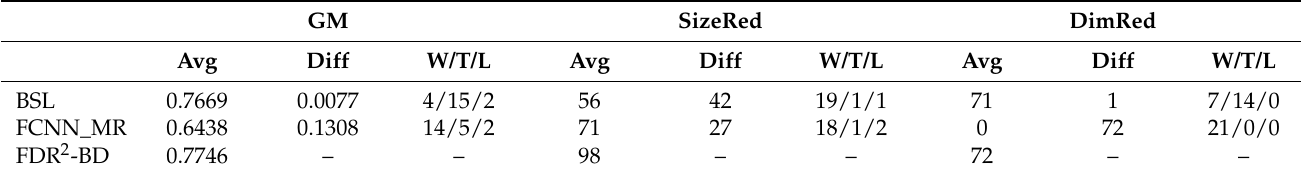
Table 7. Performance evaluation and data condensation (average, differences, and W/T/L counting). GM SizeRed DimRed